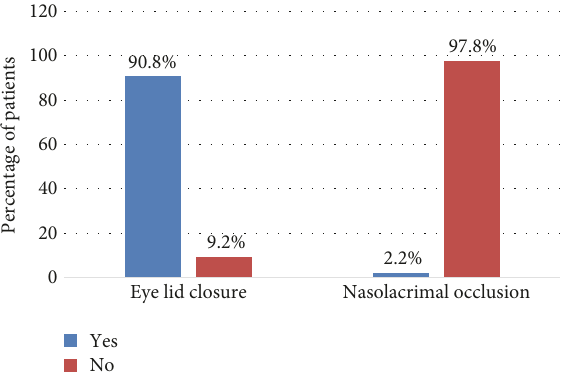
Figure 3: Percentage of practice of eyelid closure and nasolacrimal route occlusion among patients attending the glaucoma clinic of Menelik II Hospital, 2015.